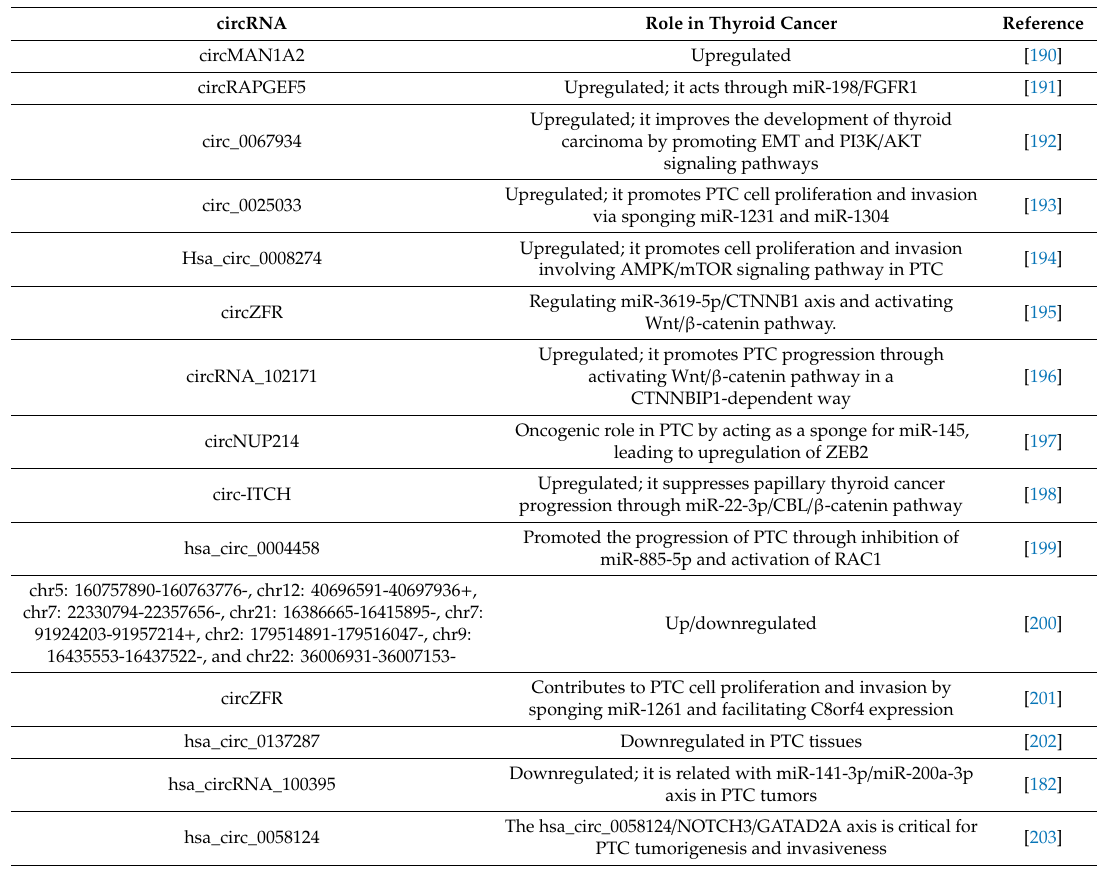
Table 5. CircRNAs described on thyroid